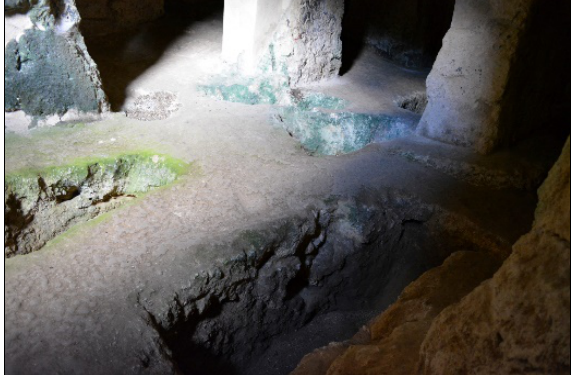
Figure 3. Lower level of the church –